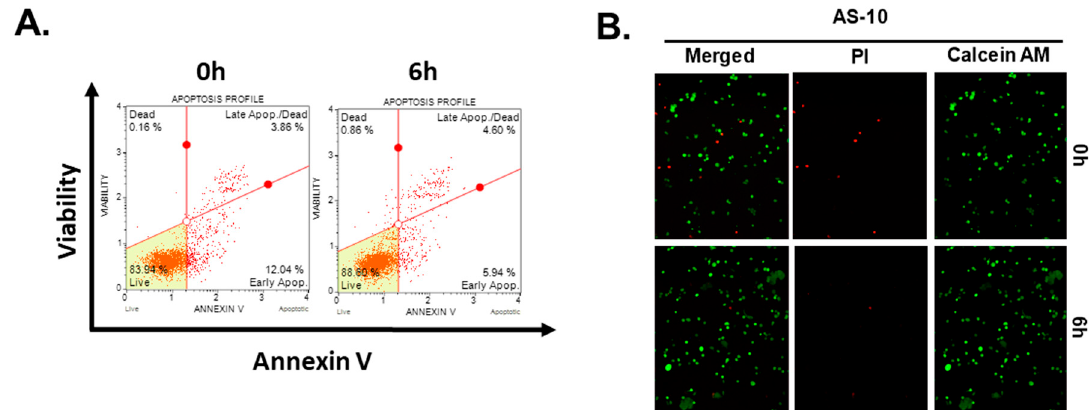
Figure A2. Cell death of Panc-1 cells treated with 10 µM AS-10 required longer than 6 h of exposure. ( A ) Live and dead Annexin V assay. Bottom-left quadrant represents healthy cells; bottom-right quadrant represents early apoptotic cells (Annexin V (+) and 7-ADD (-)); top-right quadrant represents late apoptotic/dead cells (Annexin V (+) and 7-ADD (+); Top-left quadrant represents cells that died of necrosis (Annexin V (-) and 7-ADD (+). ( B ) Fluorescence microscopy Live and Dead analysis using calcein-AM and ethidium bromide. Green indicates live cells and red indicates dead cells.